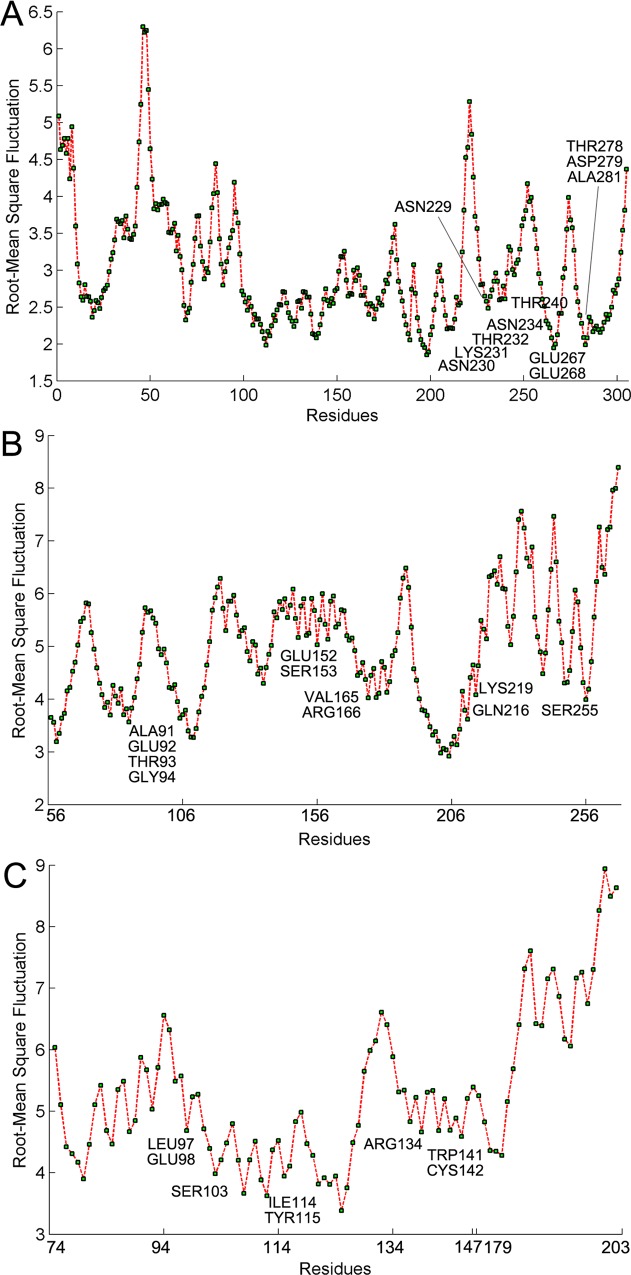
RMSF plot during molecular dynamic simulations.The figure shows backbone RMSF of GP120 (A), IN (B), and NEF (C) in molecular dynamics simulations of 10 ns. The x-axis represents protein sequences while the y-axis is average RMSF values.